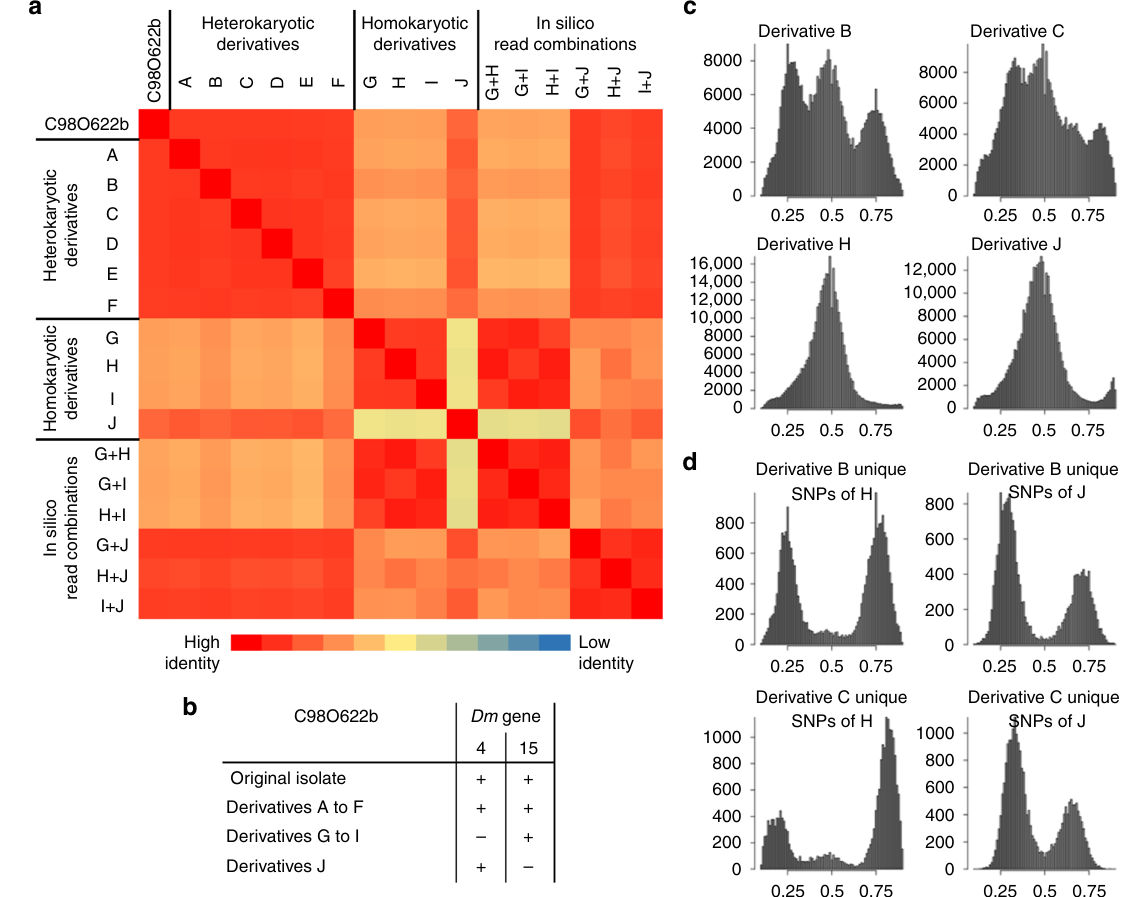
Fig. 6 Genomic and phenotypic instability of the heterokaryotic isolate C98O622b. a Relatedness analysis of ten asexual single-spore derivatives of C98O622b placed them into three genomic groups. One group of derivatives, A to F, were heterokaryotic and highly similar to C98O622b. The other two groups, derivatives G to I and derivative J, were each homokaryotic, less similar to C98O622b than the heterokaryotic group was, and even less similar to each other. Combining reads in silico of isolates G to I did not change their relatedness to other isolates; combining reads of any of G to I with J scored similarly high in relatedness to C98O622b as derivatives A to F. b Phenotypic differences between heterokaryotic and homokaryotic derivatives of C98O622b compared with the original isolate. Derivatives A to F were virulent on both Dm4 and Dm15 ; however, derivatives G to I were avirulent on Dm4 and virulent on Dm15 , while derivative J showed the reverse virulence phenotype. c Alternative allele frequency plots of four C98O622b derivatives showing that derivatives A to F are heterokaryotic and G to J are homokaryotic. Alternative allele frequency plots of the derivatives nine derivatives are shown in Supplementary Fig. 7. Derivative G is not presented as inadequate coverage was obtained (Supplementary Table 8). d Alternative allele frequency plots of heterokaryotic derivatives based only on SNPs unique to each homokaryotic derivative. In a balanced heterokaryon such as derivative B, SNPs unique to each homokaryon are observed at frequencies of 0.25 and 0.75, consistent with the presence of each nucleus in a 1:1 ratio. In an unbalanced heterokaryon, such as derivative C, SNPs unique to homokaryotic derivatives G, H, and I are present at frequencies of approximately 0.17 and 0.83, while SNPs unique to derivative J are present at frequencies of 0.33 and 0.66; this is consistent with twice as many nuclei of J as those of G, H, and I. Similar distributions are observed for derivatives A, D, and E, indicating that they are unbalanced heterokaryons (Supplementary Figs. 8, 9). Source data for panel a is provided in the Source Data fi